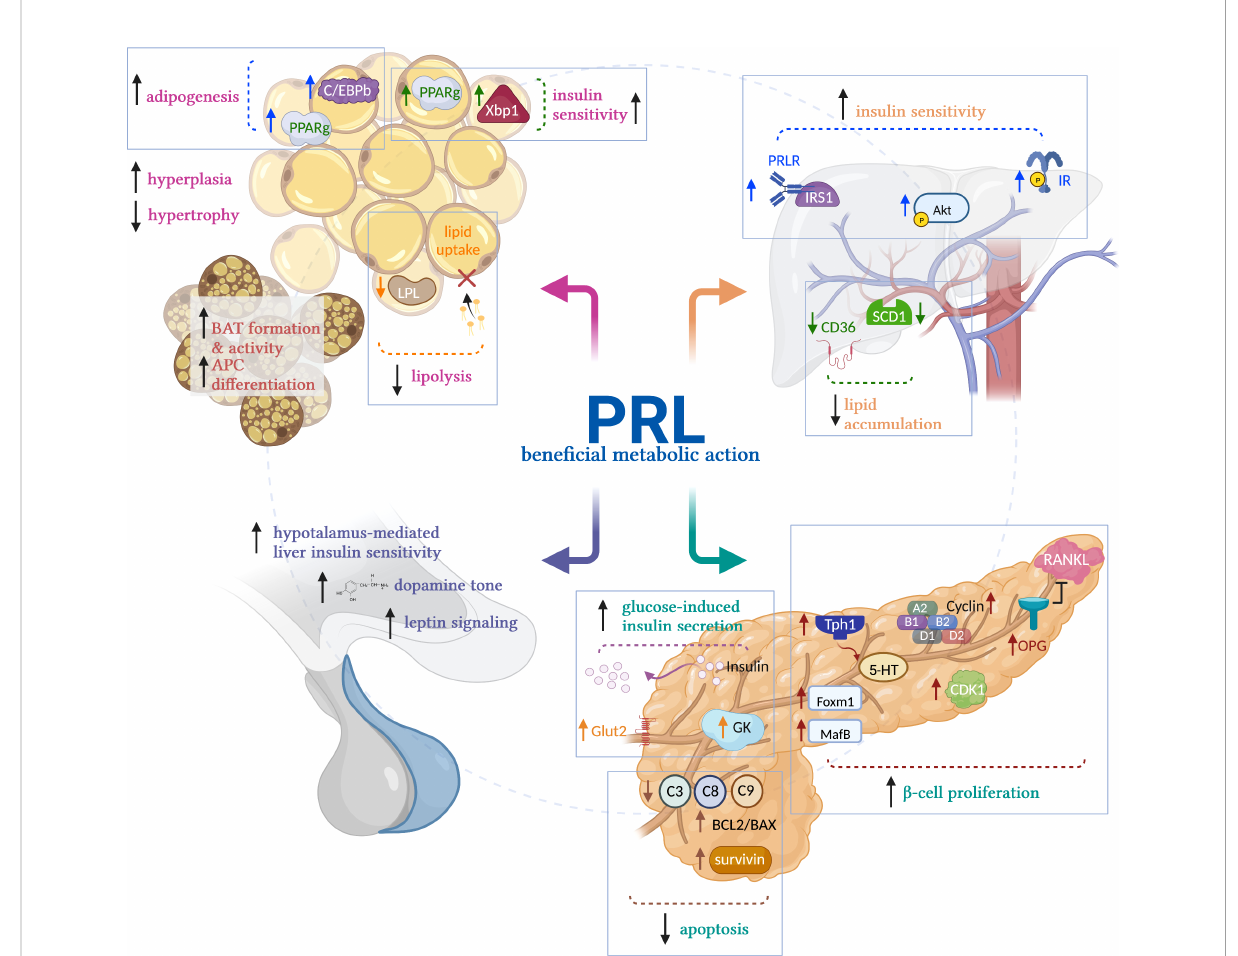
FIGURE 2 Mechanisms of prolactin ’ s bene fi cial metabolic actions. Prolactin (PRL) promotes metabolic homeostasis acting on the main metabolic tissues. In white adipose tissue, PRL reduces adipocyte size by stimulating lipolysis and reducing LPL activity, preventing lipid uptake. Also, it stimulates insulin sensitivity by activating PPARg and Xbp1s and promotes adipogenesis by activating CEBP/b and PPARg, favoring the healthy expansion of adipose tissue by hyperplasia vs hypertrophy in obesity conditions. In brown adipose tissue (BAT), PRL promotes adipocyte differentiation and BAT formation and activity in newborns. In liver, PRL promotes insulin sensitivity by its canonical signaling STAT5, and by activation of IRS1 and AKT. PRL also reduces liver lipid accumulation by reducing the activity of SCD1 and CD36, preventing aggravated fatty liver in NAFLD. In pancreas, PRL promotes b -cell proliferation, inhibits their apoptosis, and elicits glucose-induced insulin secretion. In hypothalamus, PRL promotes dopamine release and stimulates leptin signaling, inducing hypothalamus-mediated liver insulin sensitivity. LPL, lipoprotein lipase; PPARg; peroxisome proliferator-activated receptor-g; Xbp1s, spliced form of X-box-binding protein-1; CEBP/b, CCAAT/enhancer-binding protein beta; PRLR, prolactin receptor; IR, insulin receptor; IRS1, insulin receptor substrate 1; AKT, Protein kinase B; SCD1, stearoyl-CoA desaturase 1; CD36, fatty acid translocase; Tph1, tryptophan hydroxylase 1; 5-HT, serotonin; OPG, osteoprotegerin; RANKL, receptor activator of NF-kB ligand; Foxm1, forkhead box M1; MafB, MAF BZIP transcription factor B. Created in